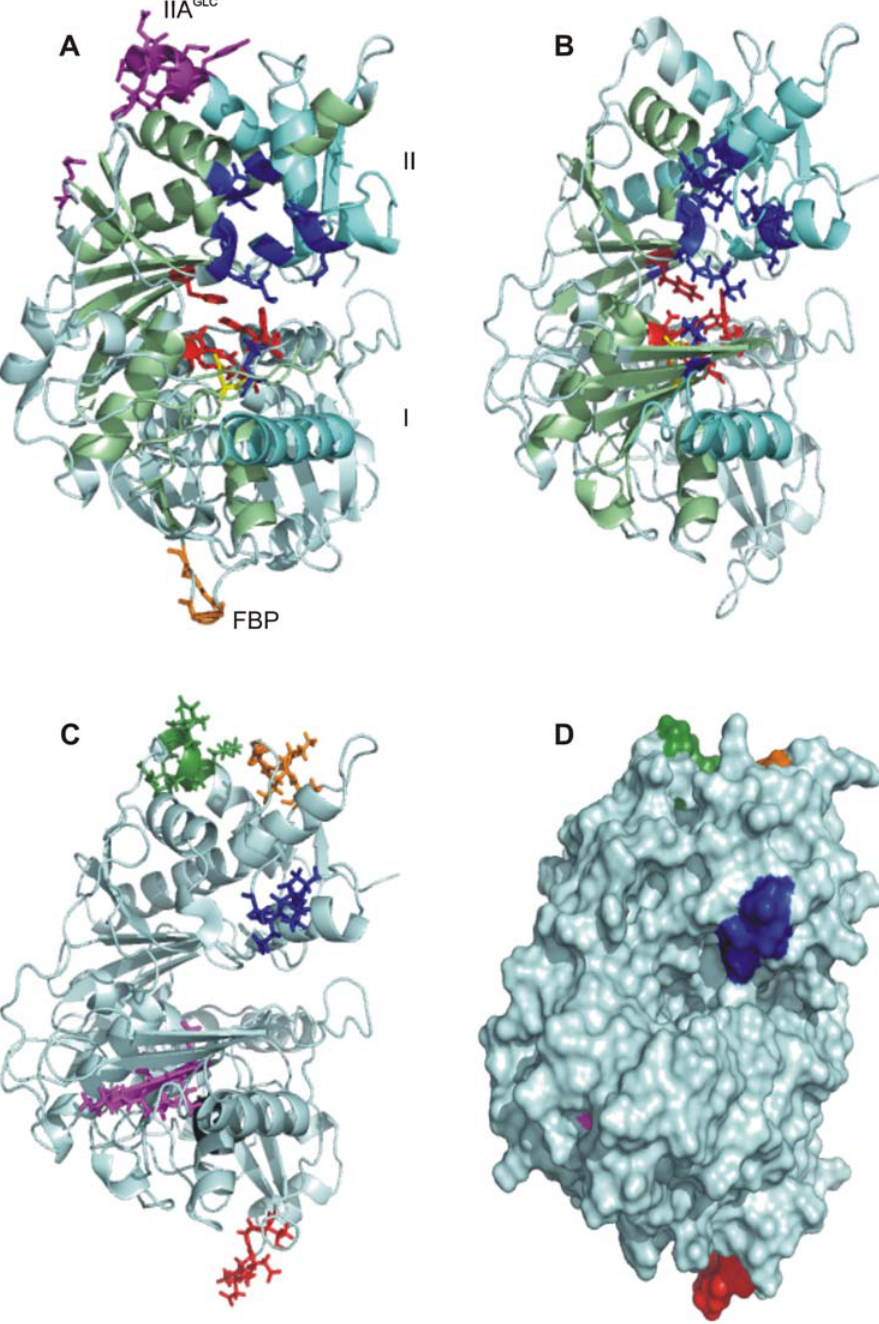
Figure 4. EcGK and PfGK models. Models A (EcGK) and B (PfGK) are displayed as ribbon structures with functional residues illustrated as sticks. (A) An EcGK monomer with residues involved in binding to ADP (blue), Mg 2 + (yellow), glycerol (red), FBP (orange) and IIA GLC (purple) [24,70]. Positions of Domains I and II are labeled. a Helices and ß sheets within Domains I and II form the ATPase domain, shaded in light green and areas involved in subunit interactions are shaded in aquamarine. (B) The PfGK model showing functional residues based on EcGK. (C) PfGK ribbon structure and (D) surface model showing potential drug target sites. Residues within each region are summarized in Table 2 and are highlighted as follows: Region I (magenta), Region II (red), Region III (black), Region IV (blue), Region V (orange) and Region VI (green). Region III is below Region I and is difficult to visualize in the ribbon configuration (C) since it is partly obscured by one of the helices. It is within the core of the molecule and cannot be seen on the surface PfGK model